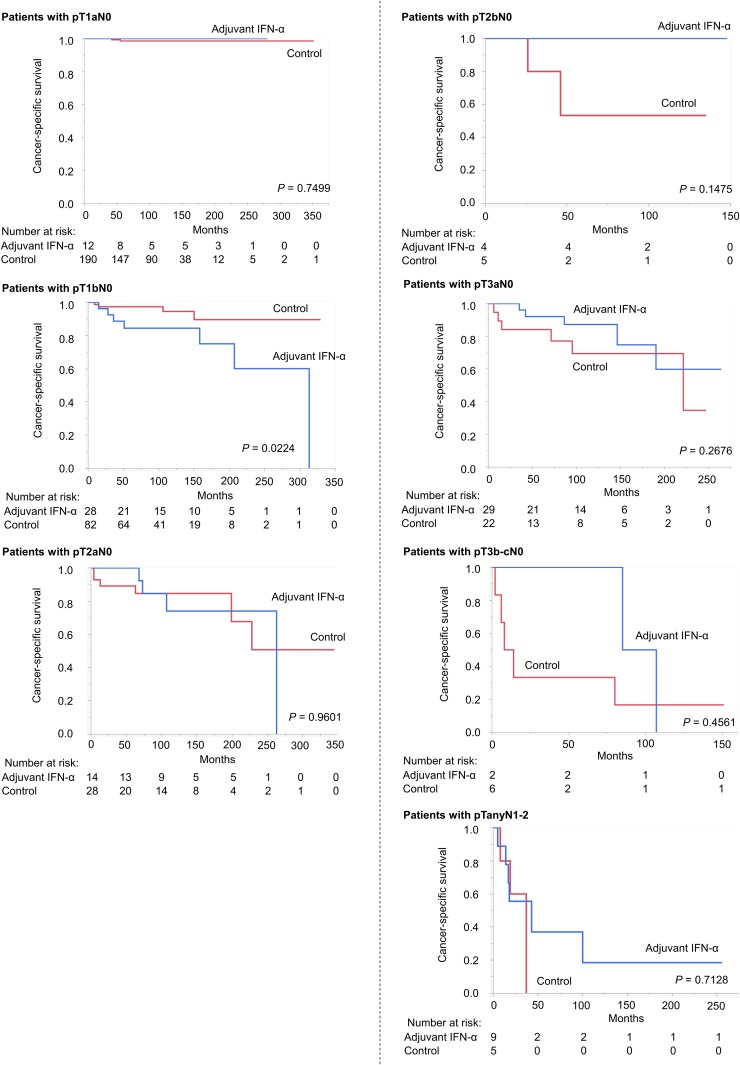
Kaplan—Meier curves depicting CSS in adjuvant IFN-α and control groups in each TNM setting.CSS in the control group was equal or superior to that in the adjuvant IFN-α group in earlier stages (pT1aN0, pT1bN0, pT2aN0), but the opposite trend was observed in more advanced stages (pT2bN0, pT3aN0, pT3b-cN0, pTanyN1-2).